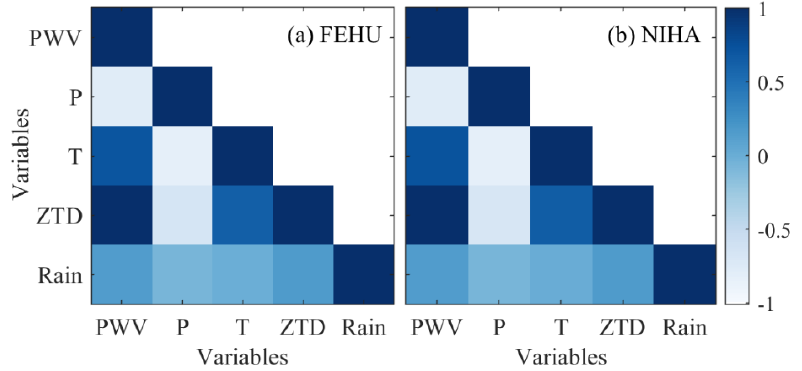
Figure 6. Correlation between multiple meteorological parameters (PWV, P, T, ZTD) and rainfall, where ( a , b ) are the results at FEHU and NIHA